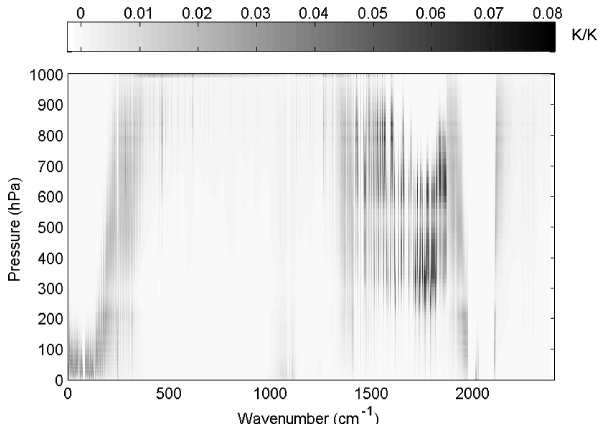
Figure 3. Temperature weighting function matrix (shaded).